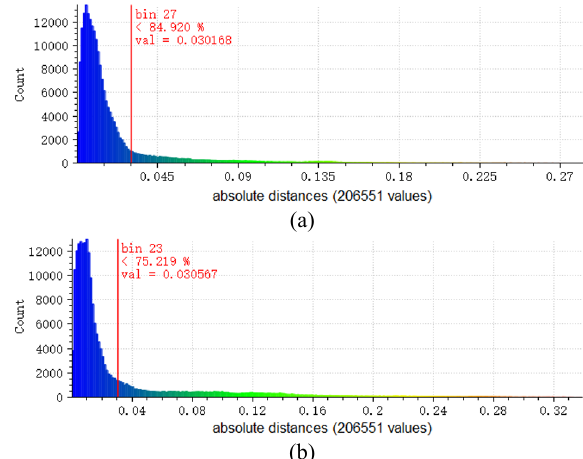
Figure 13 . The absolute distances comparison between the original laser point cloud and the dense point clouds respectively generated by the traditional method proposed by Locher and by this work: (a) comparing to the dense point cloud from the proposed method (not including the initial laser point cloud); (b) comparing to the dense point cloud from the traditional